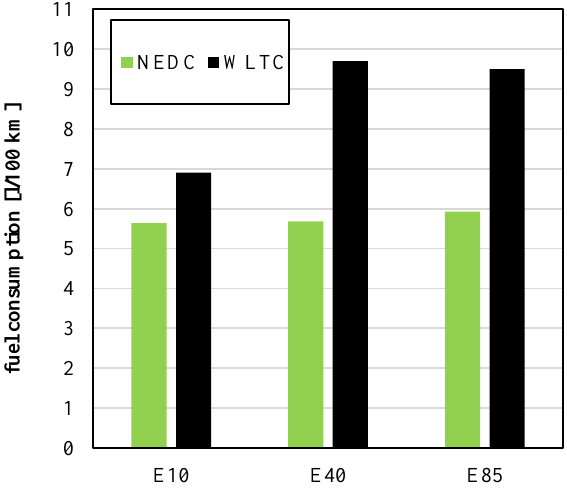
Fig. 8. Fuel consumption of a vehicle with a SI engine powered by E10, E40 and E85 fuel in the NEDC and WLTC test